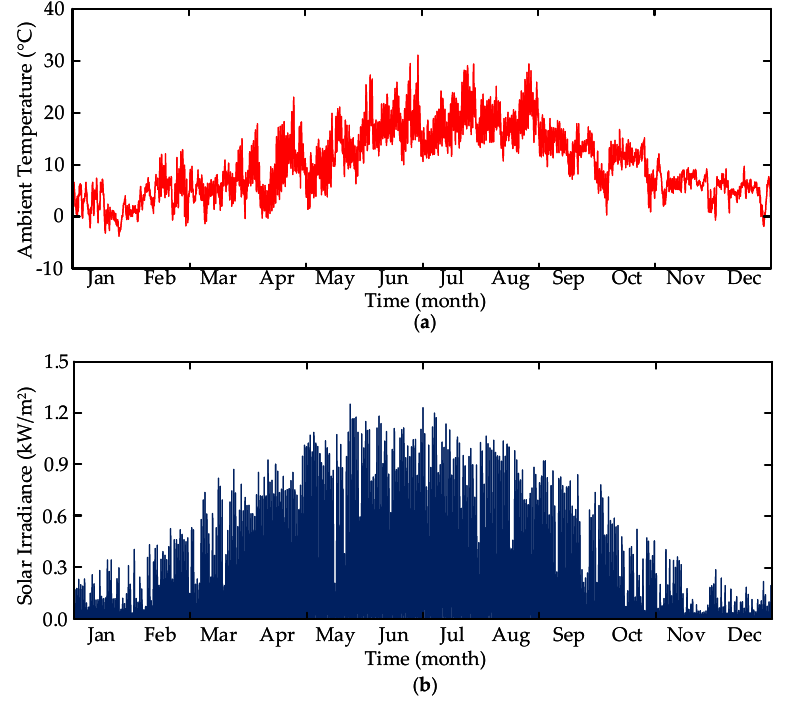
Figure 3. One-year mission profile: ( a ) ambient temperature and ( b ) solar